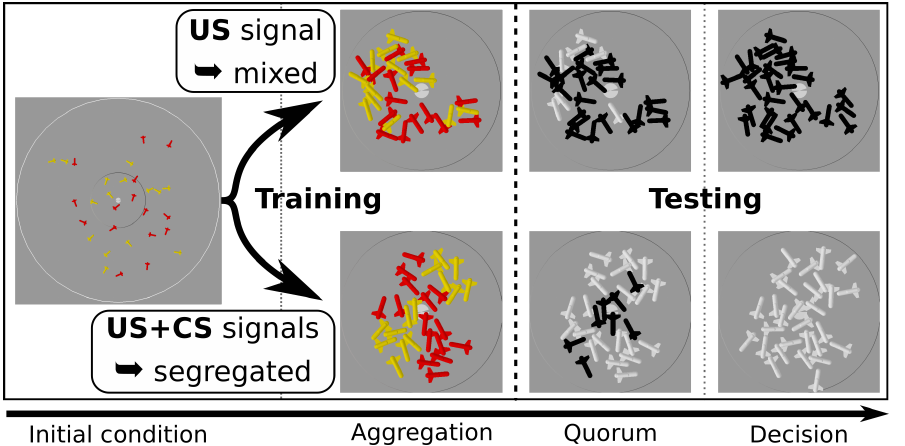
Figure 10. Snapshots of the simulated experiments, relating the different phases of the experiments and the resulting behavior of the robots. In the initial condition, the 30 robots start randomly scattered in the pool. Two different conditions are tested: in the upper part of the figure, only the unconditional stimulus (US) is presented to the robots. In the lower part of the figure, the unconditional stimulus (US) and the conditional stimulus (CS) are presented together as acoustic messages that are perceived at once by all robots. During the training phase, the robots aggregate in the range of the beacon, adopting different spatial configurations depending on the perceived stimuli. During the testing phase, each robot forms an initial opinion that is advertised using white and black colors from their status LEDs. They then carry out a quorum after which the whole group has converged to a collective decision. In these snapshots, when the robots are exposed to the US and CS stimuli during the training phase, they afterwards respond positively to the CS stimulus alone, indicating that they have learned the association. When only the US stimulus is presented during the training phase, the robots produce a negative response to the CS stimulus in the testing phase, indicating that they did not learn the